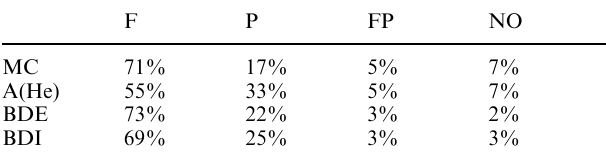
Table 4. The solar association of IP